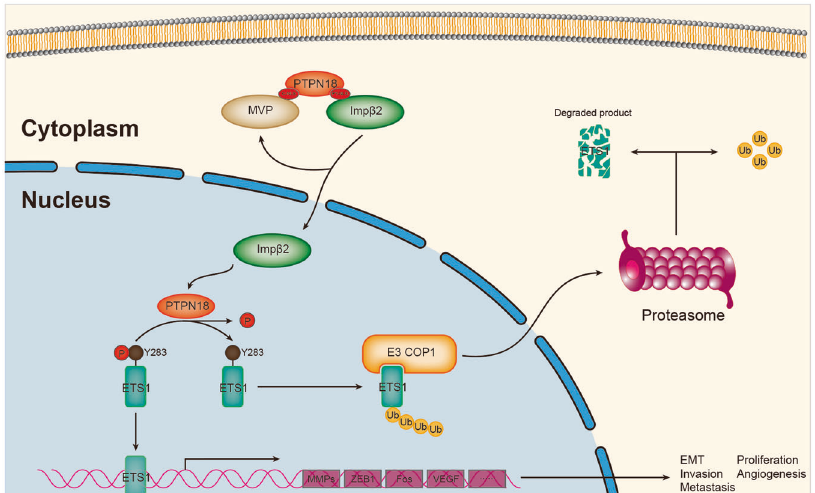
Fig. 7 Schematic diagram showing MVP- and importin β 2-mediated PTPN18 nuclear import and ETS1 stabilization regulated by nuclear PTPN18. PTPN18 interacts with MVP through cNLS, and interacts with importin β 2 through PY-NLS, which synergistically promote the translocation of PTPN18 into the nucleus. PTPN18 is carried into the nucleus by importin β 2. Nuclear PTPN18 can speci fi cally recognize the substrate ETS1 and dephosphorylate its Y283 site, which promotes the degradation of ETS1. Nuclear PTPN18 inhibits breast cancer cell EMT, invasion and metastasis by regulating the